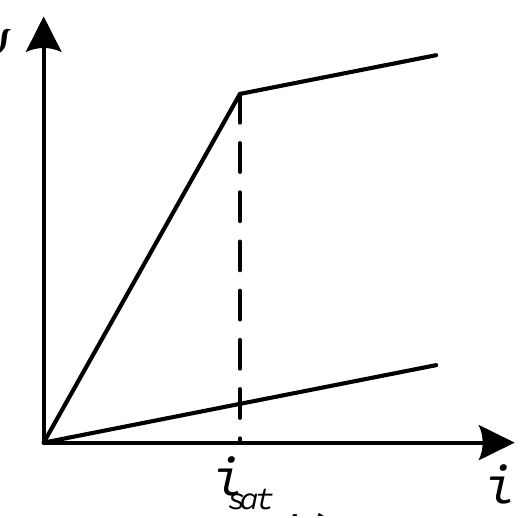
Figure 7. Linearized magnetization profile of SRM model.